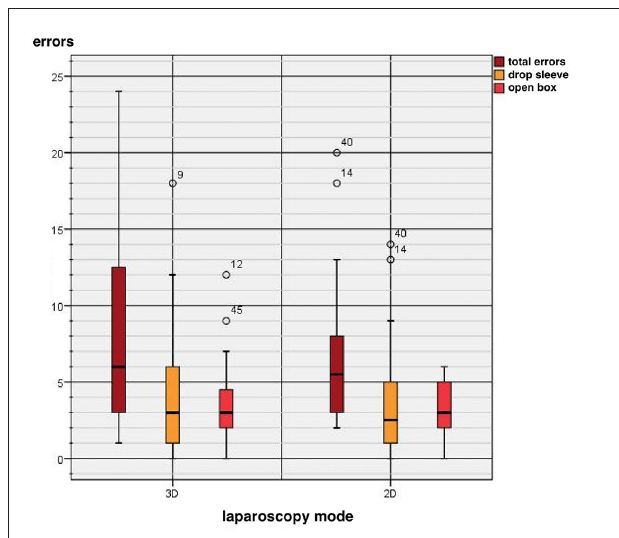
FIGURE 4 | Comparison between two-dimensional (2D) and three-dimensional (3D) systems regarding technical